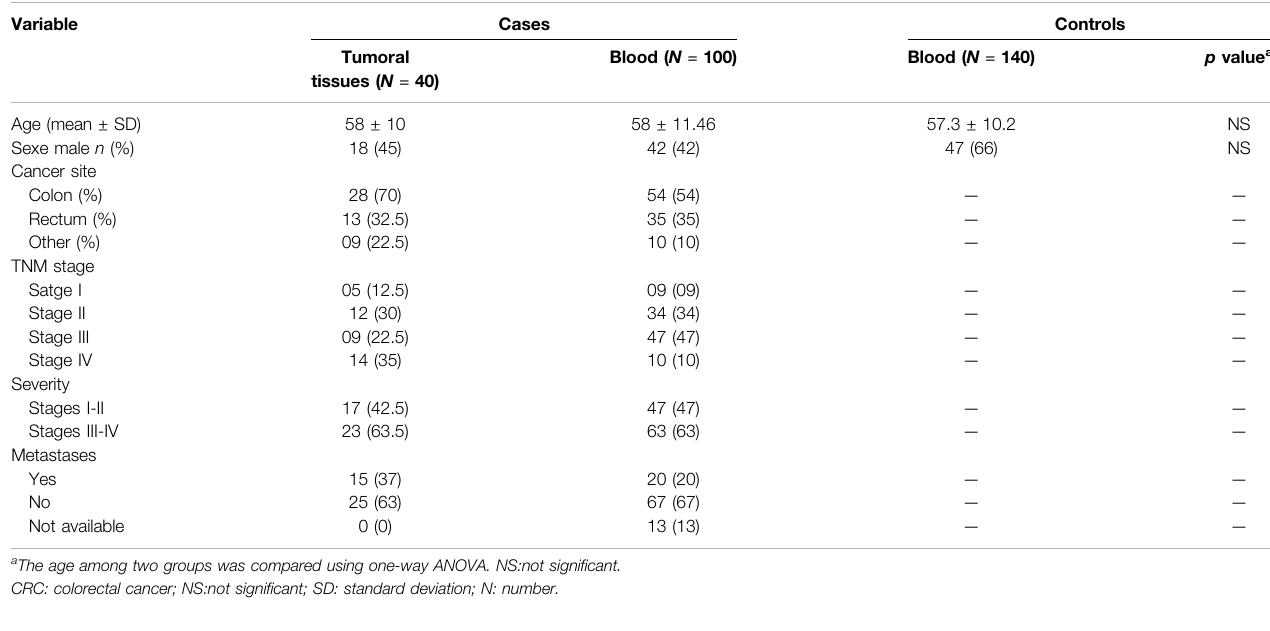
Frontiers in Genetics |